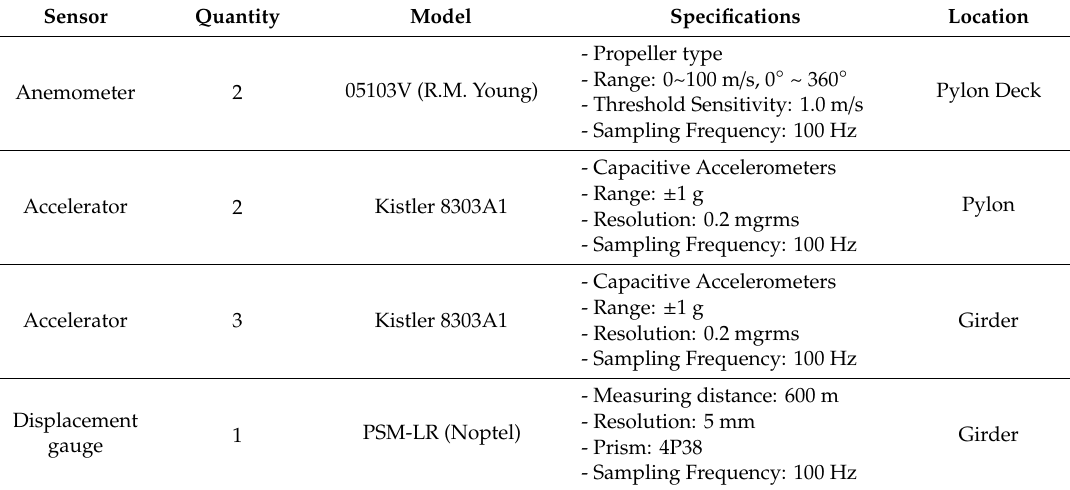
Figure 1. Longitudinal view of the bridge with the sensor positions. Table 1. Specifications of